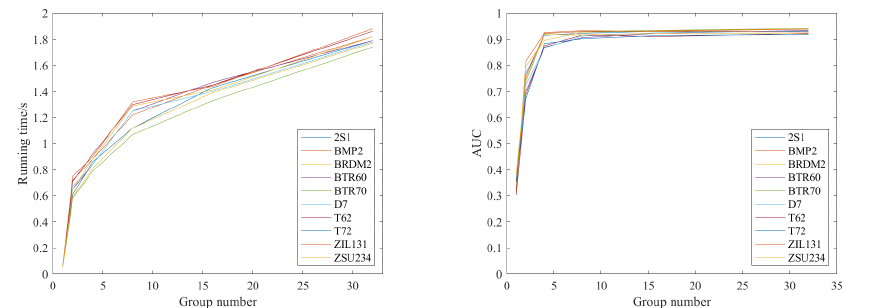
Figure 8. Running time and AUC for 10 classes of vehicles with different G . The left figure is running time with G = 1,2,4,8,16,32. The right figure is AUC when the top 15% highlighted pixels are conserved. ( θ = 15% in insertion check) with G =